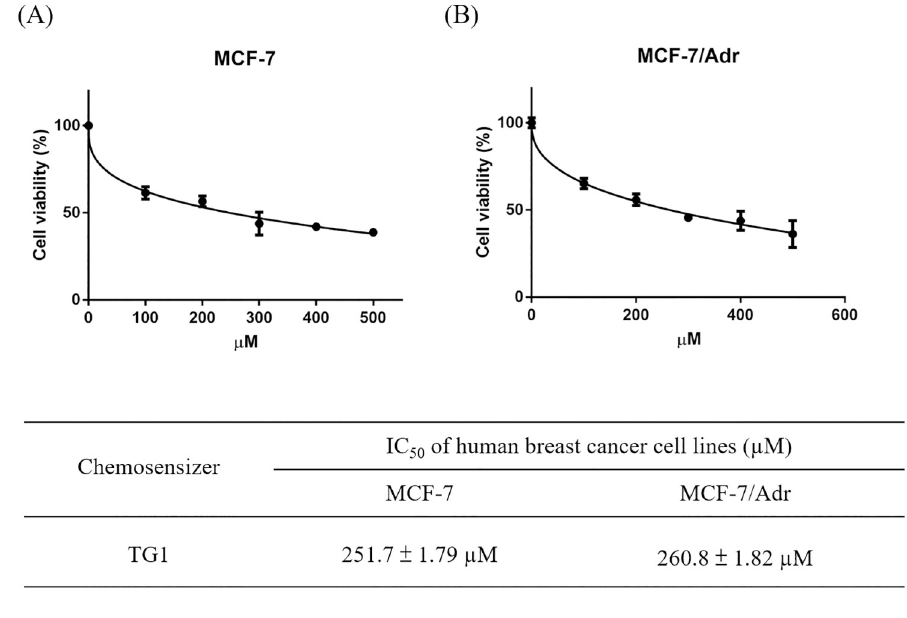
Fig 4. Inhibition of TG1 on proliferation of (A) MCF-7 and (B) MCF-7/Adr cells. The IC 50 values of TG1 were calculated and showed on table. Data were shown by mean ± SD, n = 3.